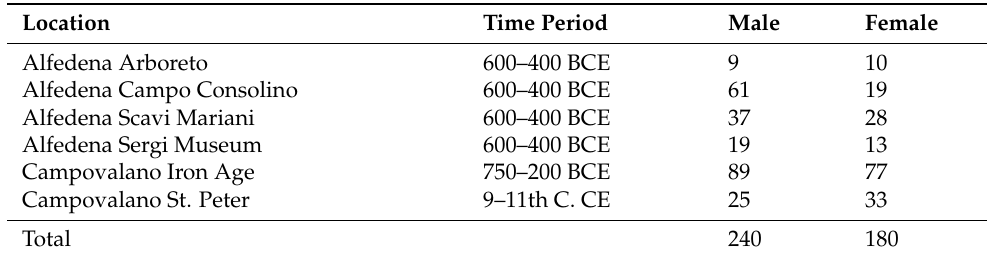
Table 1. Location, time period, and sex distributions for males and females from Central Italy used in this study.